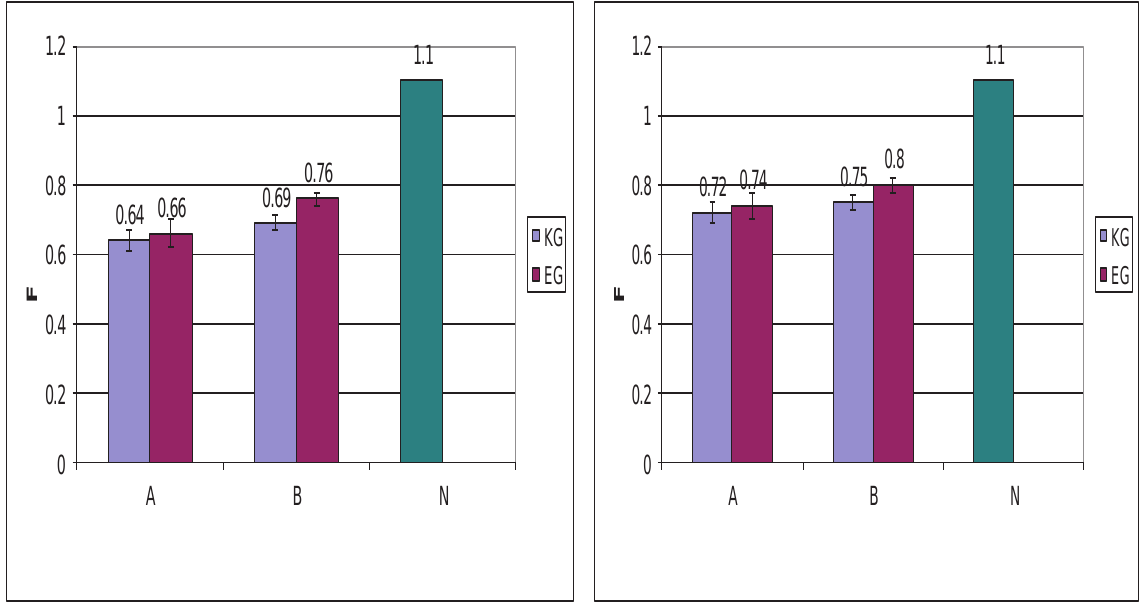
Fig. 3. The magnitude of phosphorus excretion (F – g/day) in children aged 12-13 years in rest (A) and after physical culture lesson (B) (n=40): A – at the beginning of the study, B – at the end of the study, N – norm, KG – control group, EG – experimental